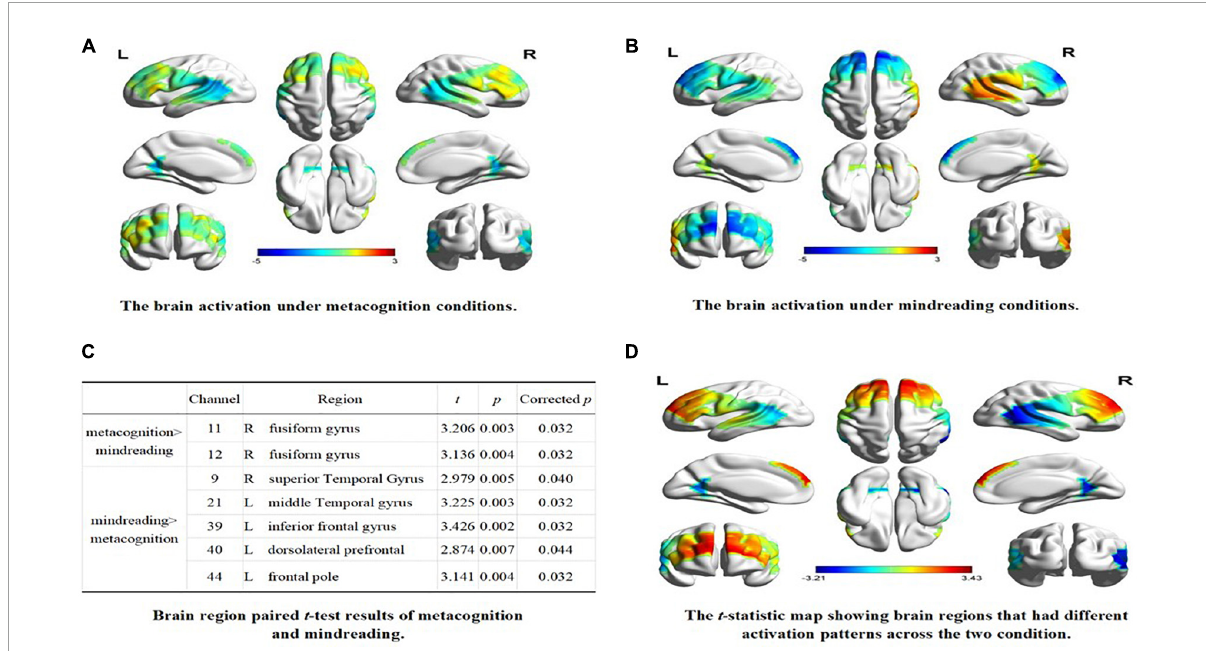
FIGURE2 The brain activation under different conditions. (A) The brain activation under metacognition conditions. (B) The brain activation under mindreading conditions. (C) Brain region paired t -test results of metacognition and mindreading. (D) The t -statistic map showing brain regions that had different activation patterns across the two